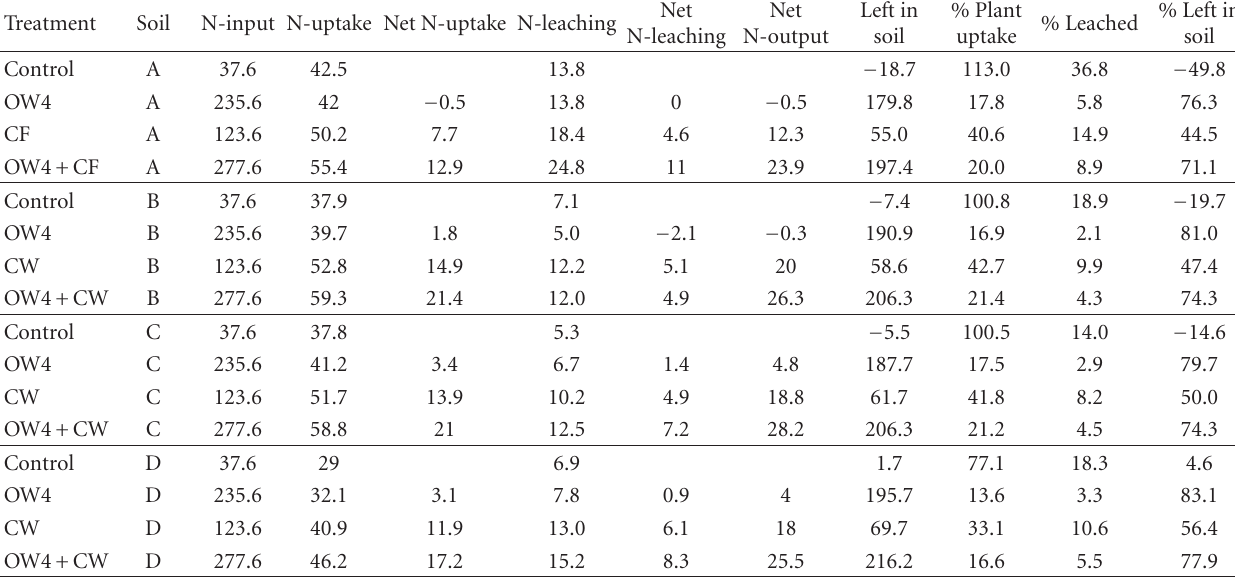
Table 5: Total amount of N (gN m − 2 ) in (atmospheric N input (1.6gN m − 2 ) + N in organic/inorganic fertilizer) and out (N in plants + N leached) of the soil columns during the experimental period. The distribution of N between plant uptake, leached or left in soil is also given as % of input N (fertilizer + atmospheric N input).